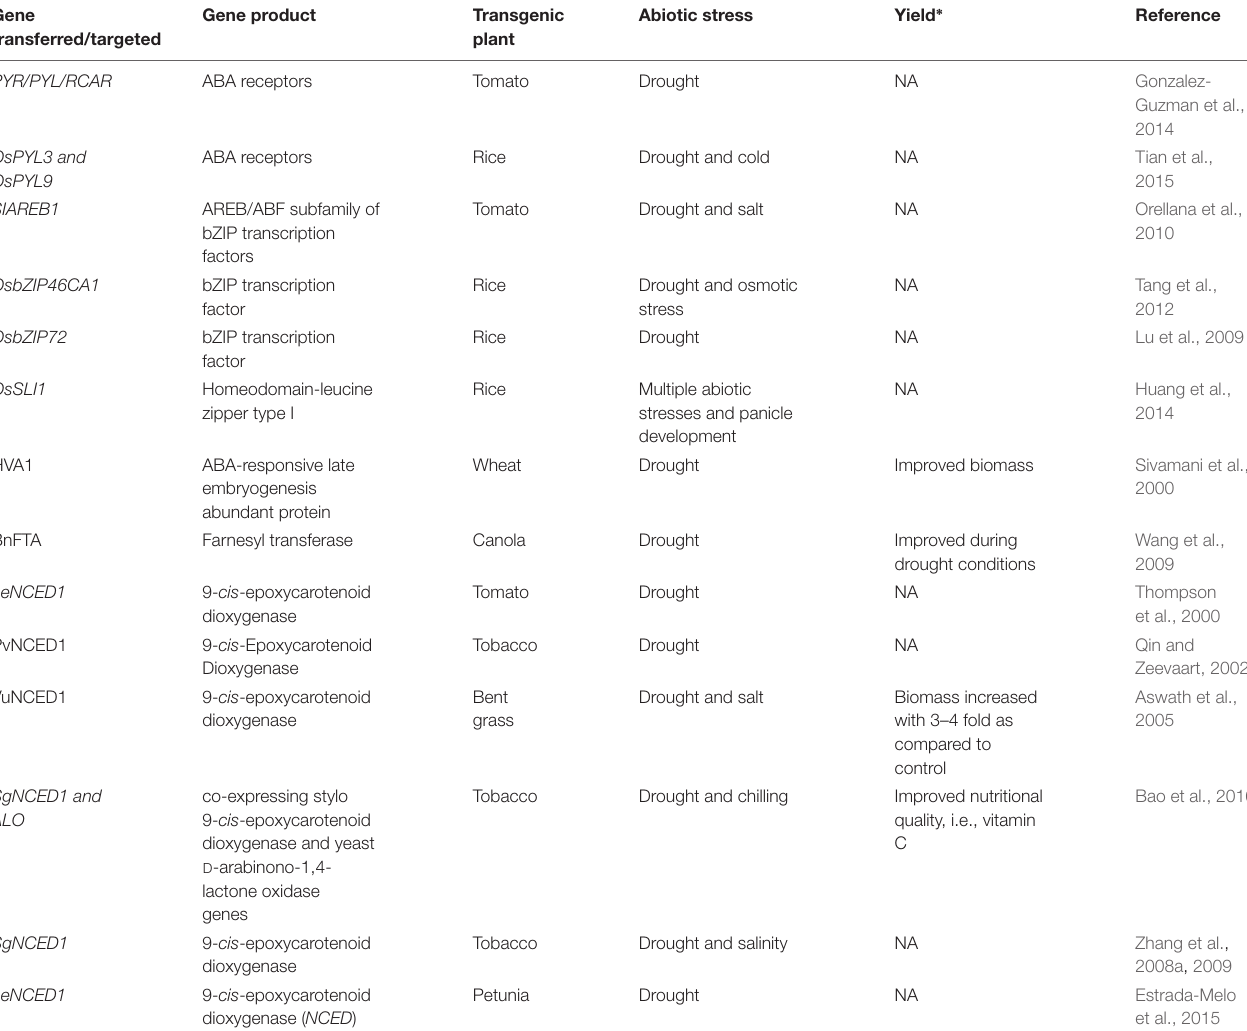
TABLE 1 | List of transgenic plants that used genes for improved abiotic stress tolerance through manipulating ABA signaling or synthesis in crops. Gene